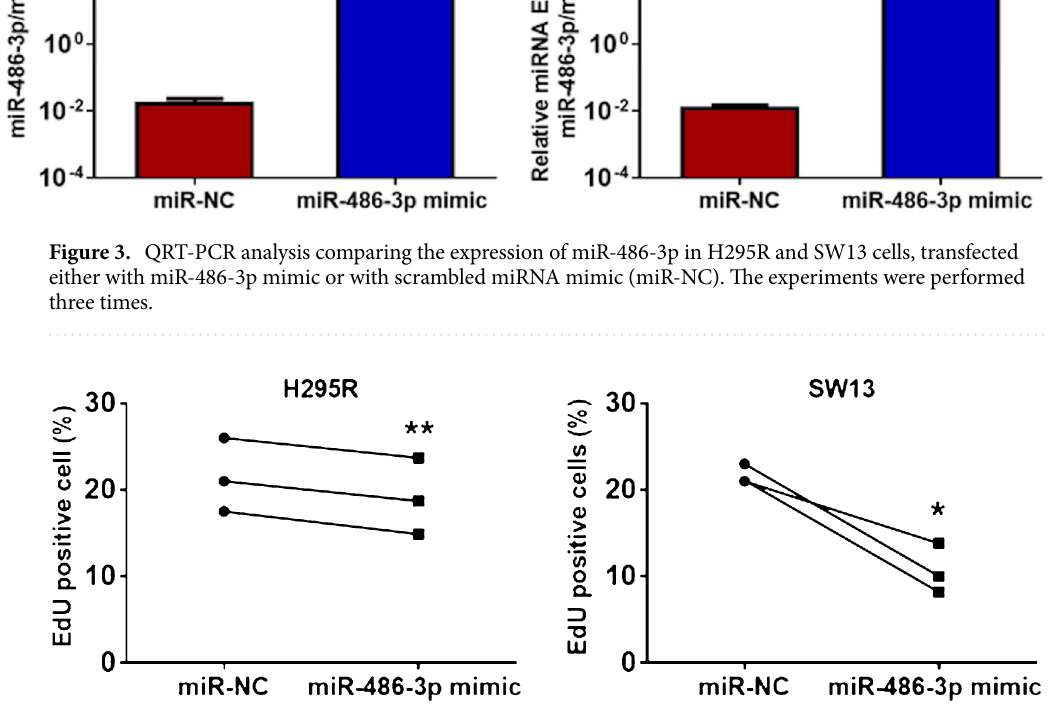
Figure 4. Cell proliferation analysis using EdU flow-cytometry assay. H295R and SW13 cells were transfected with miR-486-3p mimic and miR-NC (control cells) for two days. EdU incorporation was significantly inhibited in H295R miR-486-3p mimic cells ( p < 0.01) and SW13 miR-486-3p mimic cells ( p < 0.05) compared to miR-NC cells. The experiments were performed three